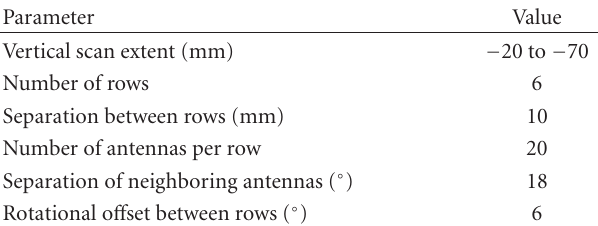
Table 2: TSAR scan